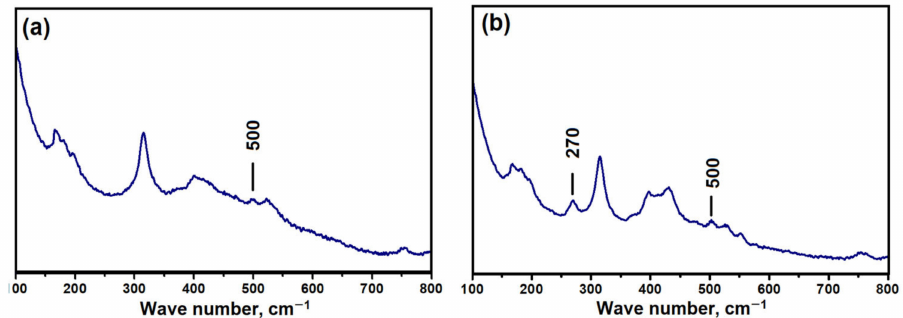
Figure 3. Raman spectra of silicoaluminophosphate gels: ( a ) Sample-SAPO-iAl-1.0; ( b ) Sample-SAPO-